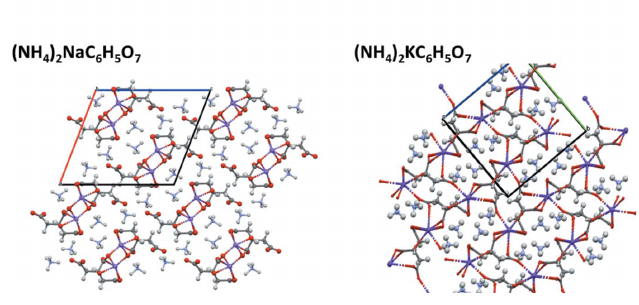
Figure 9 The crystal structure of (II), viewed nearly down the b -axis direction, to better illustrate the chains.